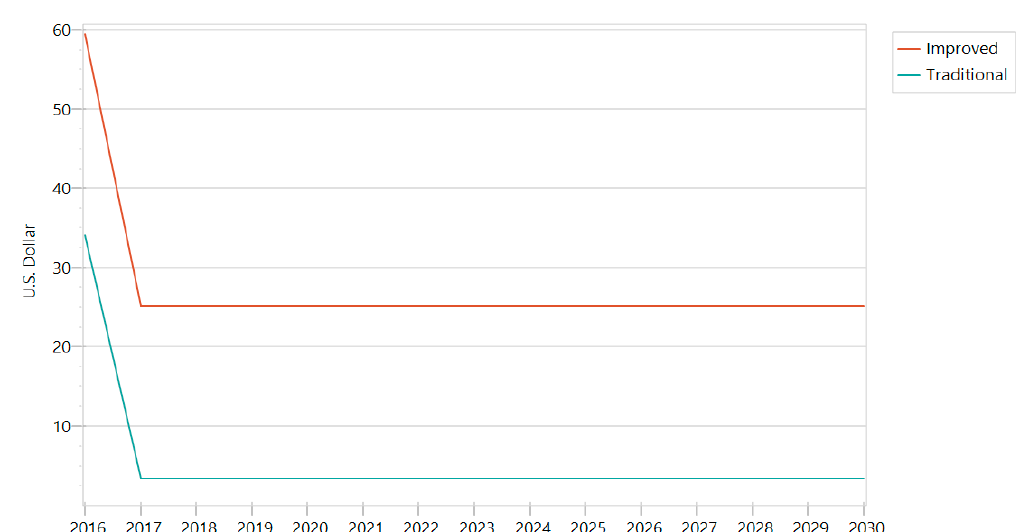
Figure 4. Annualized cost of improved stoves for urban households.